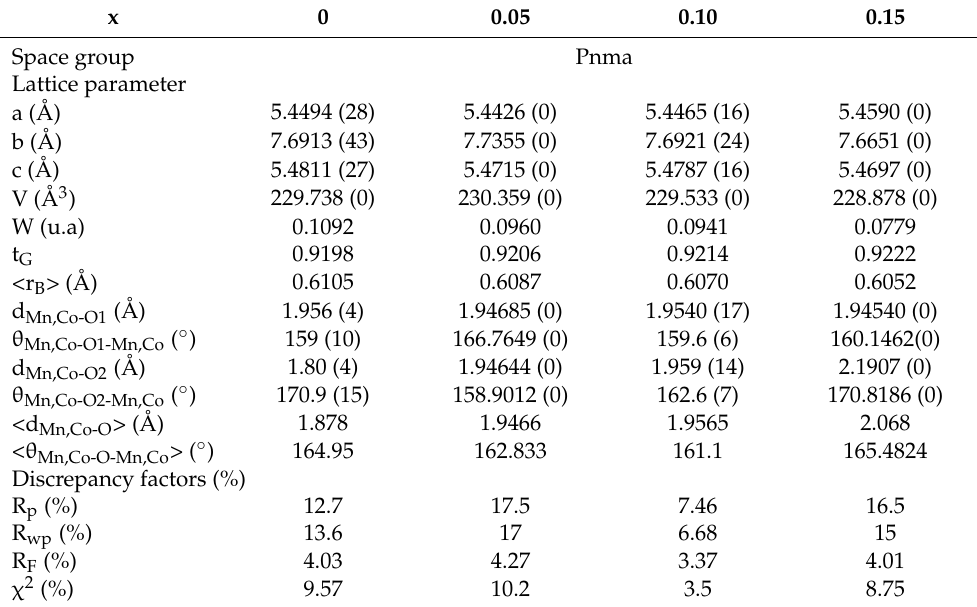
Table 2. Structural parameters refined by the Rietveld method of compounds Pr 0.7 Sr 0.3 Mn ( 1 − x ) Co x O 3 (0 ≤ x ≤ 0.15) at room